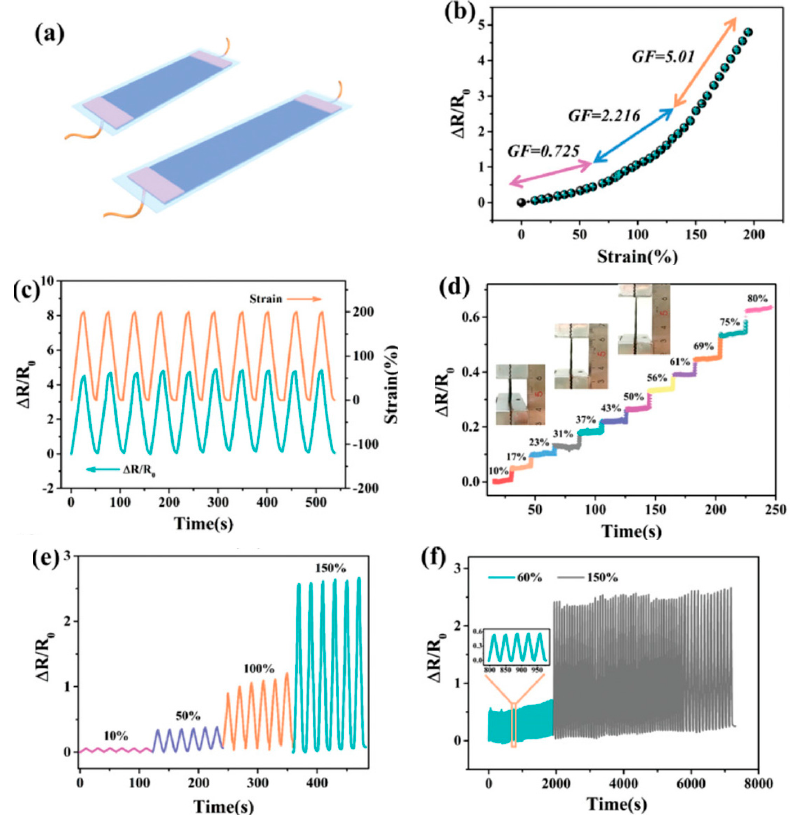
Figure 19. Proof-of-concept of the PVA/SA/BC/MCC hydrogel as piezoresistive strain sensor. ( a